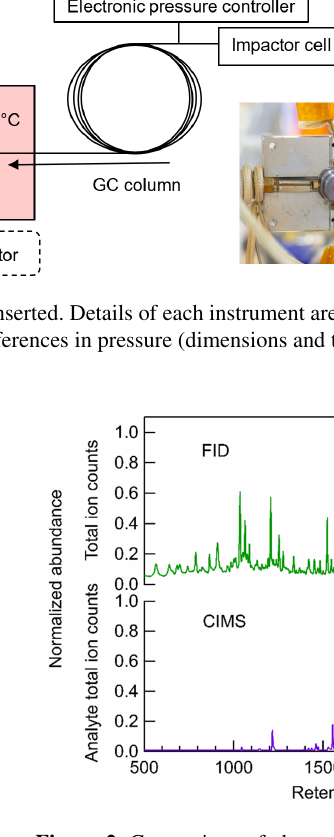
Figure 2. Comparison of chromatograms between FID and CIMS from particle sample generated from limonene–O 3 reaction. The time-series signals of CIMS are the analyte total ion counts, which are the summation of all ions with the reagent ions removed, while signals of FID are single channel. The signals of both CIMS and FID are normalized to the highest peak in the